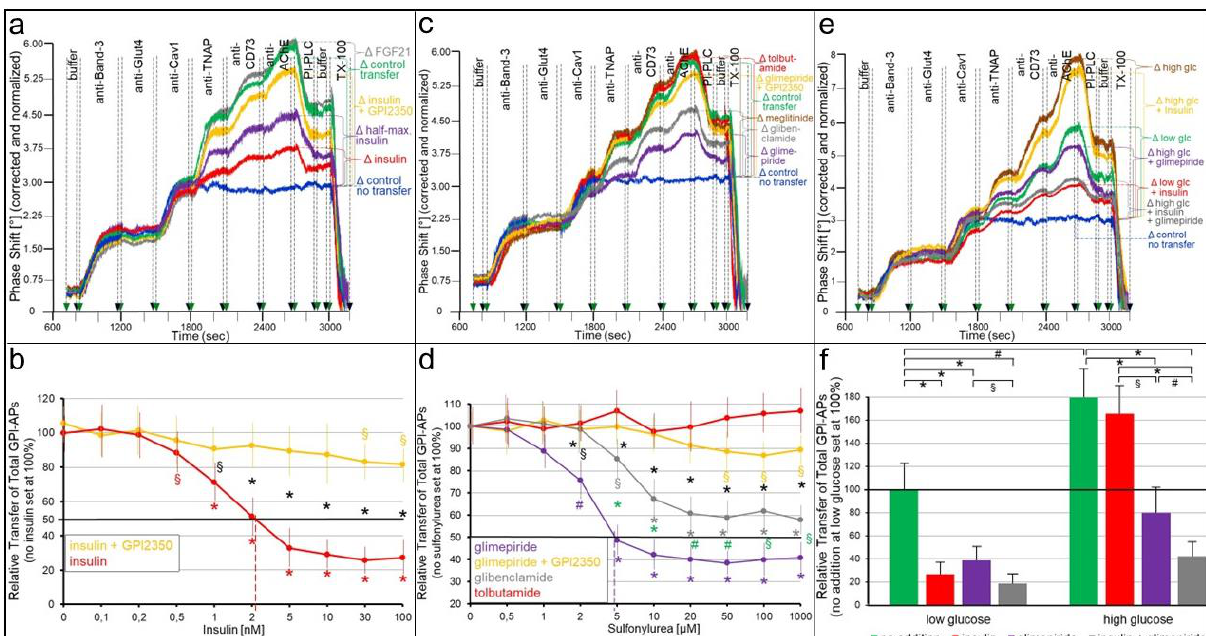
Figure 3. Inhibition of GPI-AP transfer from human adipocytes to ELCs by insulin and antidiabetic SUs. ( a , c , e ) Transwell co-cultures were run with human donor adipocytes (of lipid-loading stage II) or only medium (control no transfer) and GPI-deficient EL acceptor cells in the insert and bottom wells, respectively, as described in Section 4. After incubation (1 week, 37 °C) in the absence (control transfer) or presence of ( a ) human insulin (30 nM or 2 nM for half-max.) without or with the GPI-PLC inhibitor GPI2350 (100 µ M) or of human FGF21 (50 nM), ( c ) tolbutamide (1 mM), glibenclamide (20 µ M) or glimepiride (20 µ M) without or with GPI2350 (100 µ M) or of meglitinide (50 µ M) and ( e ) glucose (5 mM for low glc; 20 mM for high glc) without or with insulin (30 nM) and/or glimepiride (20 µ M), PMs were prepared from the ELCs of the bottom wells, coupled to chips by ionic/covalent capture and then analyzed for the expression of membrane proteins by SAW sensing, as described for Figure 1. Phase shifts induced by the binding of antibodies against GPI-APs or transmembrane proteins and by PI-PLC and TX-100 treatments (700–3200 s) are shown only, omitting the preceding capturing of PMs (0–700 s). The correction and normalization of the phase shift were performed as described for Figure 1. Phase shift ∆ between the injection of the first (at 1800 s) and last antibody against GPI-APs (at 2700 s) are indicated by the horizontal, hatched lines and brackets for the various incubations. ( b , d ) The experiments (see a , c ) were repeated three to six times with incubations at increasing concentrations of human insulin ( b ) or SUs ( d ) in the absence or presence of GPI2350 (100 µ M). Phase shift ∆ induced by antibodies against TNAP, CD73 and AChE (1800–2700 s) were corrected for those with medium alone in the insert wells (control no transfer) and used for the calculation of the relative transfer of total GPI-APs with the absence of insulin and SUs, respectively, set at 100% each. Significant differences between the absence and presence of insulin ( b ) or SUs ( d ) at the various concentrations, as well as between the absence and presence of GPI2350 for incubations with insulin ( b ) or glimepiride ( d ) at each concentration and between glimepiride and glibenclamide at each concentration ( d ) are indicated with the black and green symbols ( b , d ) and correspondingly colored symbols ( d ), respectively. ( f ) The experiments (see e) were repeated four or six times (distinct co-cultures) for incubations at low (0.1 mM) or high (5 mM) glucose in the absence (green bars) or presence of insulin (30 nM; red bars), glimepiride (20 µ M; turquoise) or insulin together with glimepiride (grey bars). Phase shift ∆ induced by antibodies against TNAP, CD73 and AChE (1800–2700 s) were corrected for those with medium alone in the insert wells (absence of insulin and SUs) and used for the calculation of the relative transfer of total GPI-APs (no addition at low glucose set at 100%). Significant differences between the relative transfer of total GPI-APs at low or high glucose at each addition are indicated (means ± SD; * p ≤ 0.01, # p ≤ 0.02, § p ≤